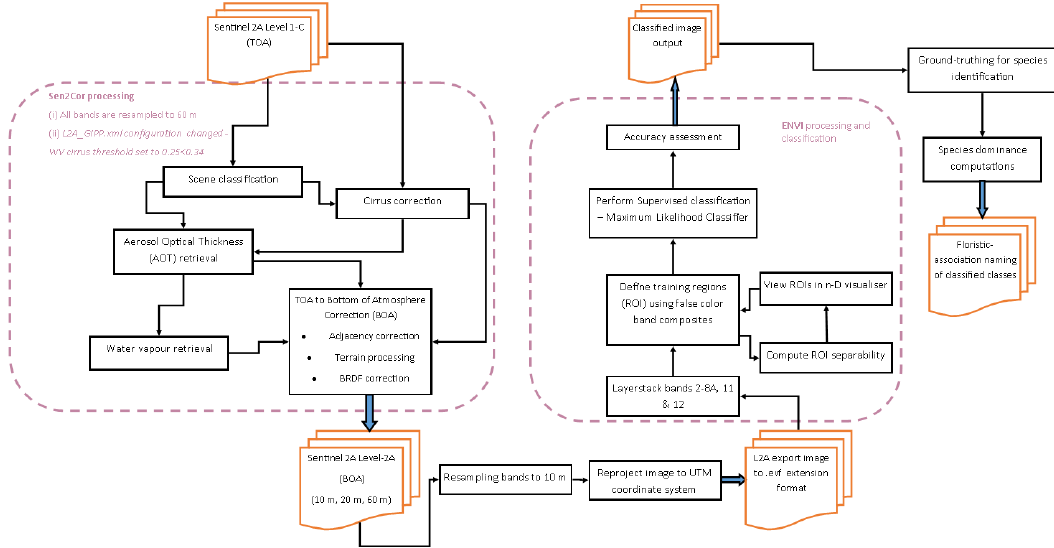
Figure 2 . Workflow process for processing the Level-1C imagery in ESA SNAP environment, to classification in ENVI environment to eventually determining the floristic-association naming for output classification classes. The first group processes occurred in the SNAP software and involved processes to perform atmospheric correction. The second group are processes that occurred in the ENVI software environment to perform the image feature extraction and classification processes.